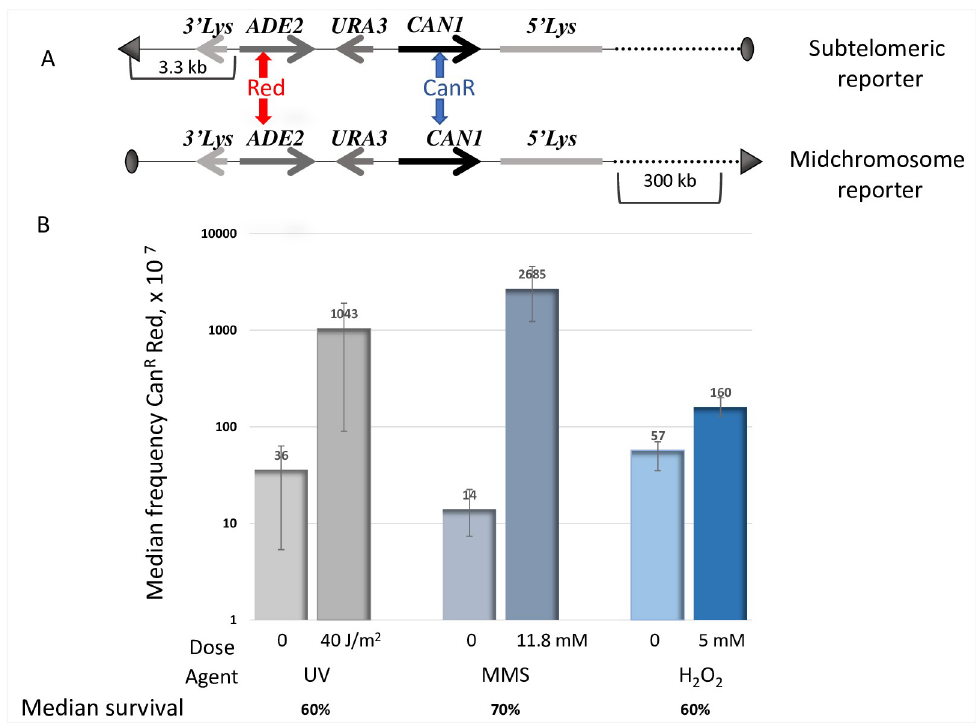
Fig 1. Exogenous DNA-damaging agents induce closely spaced mutations in ssDNA. A. Schematic representation of the triple-reporter system for direct detection of clustered mutations in ssDNA. Subtelomeric reporter: CAN1 , URA3 , and ADE2 genes were placed within disrupted LYS2 gene, close to de novo constructed telomere at Chromosome V in the cdc13-1ts mutant strain. At 37˚C, uncapping of telomeres and prevention of resynthesis of the resected telomeres in cdc13- 1ts cells results in persistent ssDNA comprising the reporter genes up to 6 hours without significant loss of viability. Simultaneous mutations in CAN1 (blue vertical arrows) and ADE2 (red vertical arrows) give rise to CanR Red colonies. Midchromosome reporter: CAN1 , URA3 , and ADE2 genes were placed in the middle of the right arm of Chromosome II, more than 300 kb away from either telomere. The horizontal arrowheads show the direction of the transcription of the corresponding genes. Telomeres are depicted as triangles and centromeres as ovals. B. In ssDNA, oxidative DNA- damaging agent, hydrogen peroxide, at a dose equitoxic to that of MMS and UV, induces less closely spaced (CanR Red) mutations than either of these mutagens. All experiments were carried out as described in Materials and methods. Mutation frequencies for six to 12 independent cultures were measured in each experiment. Median frequencies of spontaneous mutations for each type of exposure are shown separately because the technical settings of these experiments were slightly different: in order to achieve the same level of toxicity for different mutagens, the time of the exposure to MMS and mock exposure in the corresponding controls was adjusted to 30 minutes, whereas the time of incubation of the cells with hydrogen peroxide and the corresponding mock incubation in water lasted 2 hours. Therefore, the longer time of persistence of ssDNA in the controls for hydrogen peroxide exposure could have contributed to an elevated basal level of spontaneous mutations, compared to the levels of mutations spontaneous in experiments involving MMS. Whiskers represent 95% confidence limits for median frequency of mutations. See also S1 Data. CanR Red, canavanine-resistant red; H 2 O 2 , hydrogen peroxide; MMS, methyl methanesulfonate; ssDNA, single-strand DNA; UV, ultraviolet